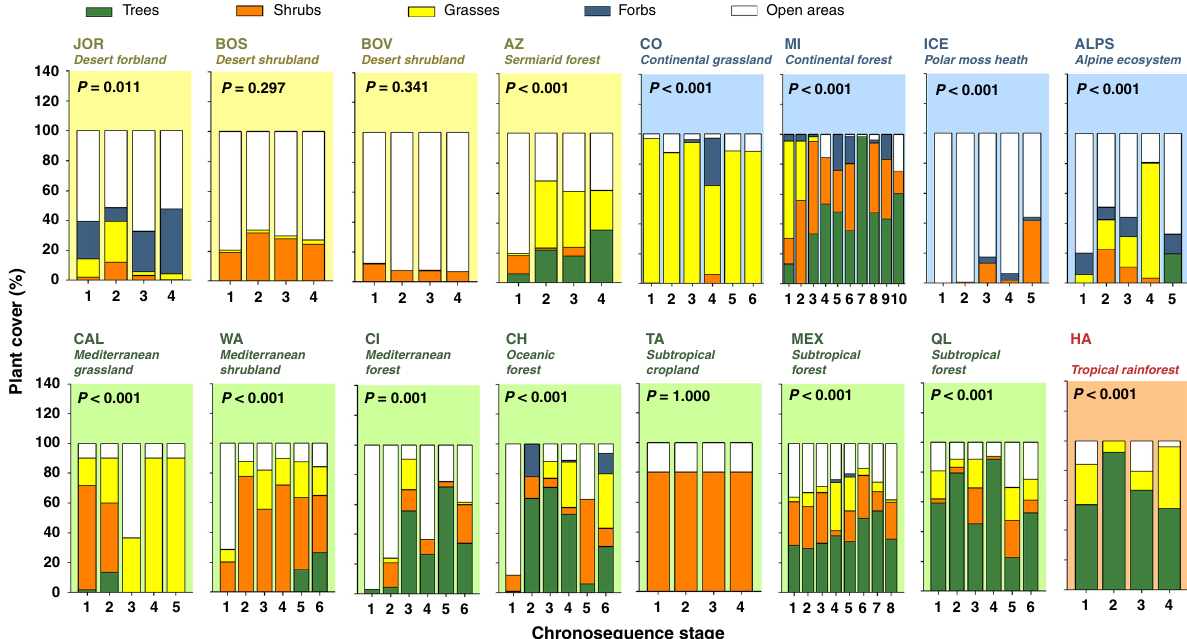
Fig. 7 Changes in plant community structure during ecosystem development. Plant cover (mean values) = %. Acronyms for different chronosequences are available in Supplementary Fig. 1. PERMANOVA P -values are shown. Chronosequence stage was included as a fi xed factor in these analyses ( n = 3